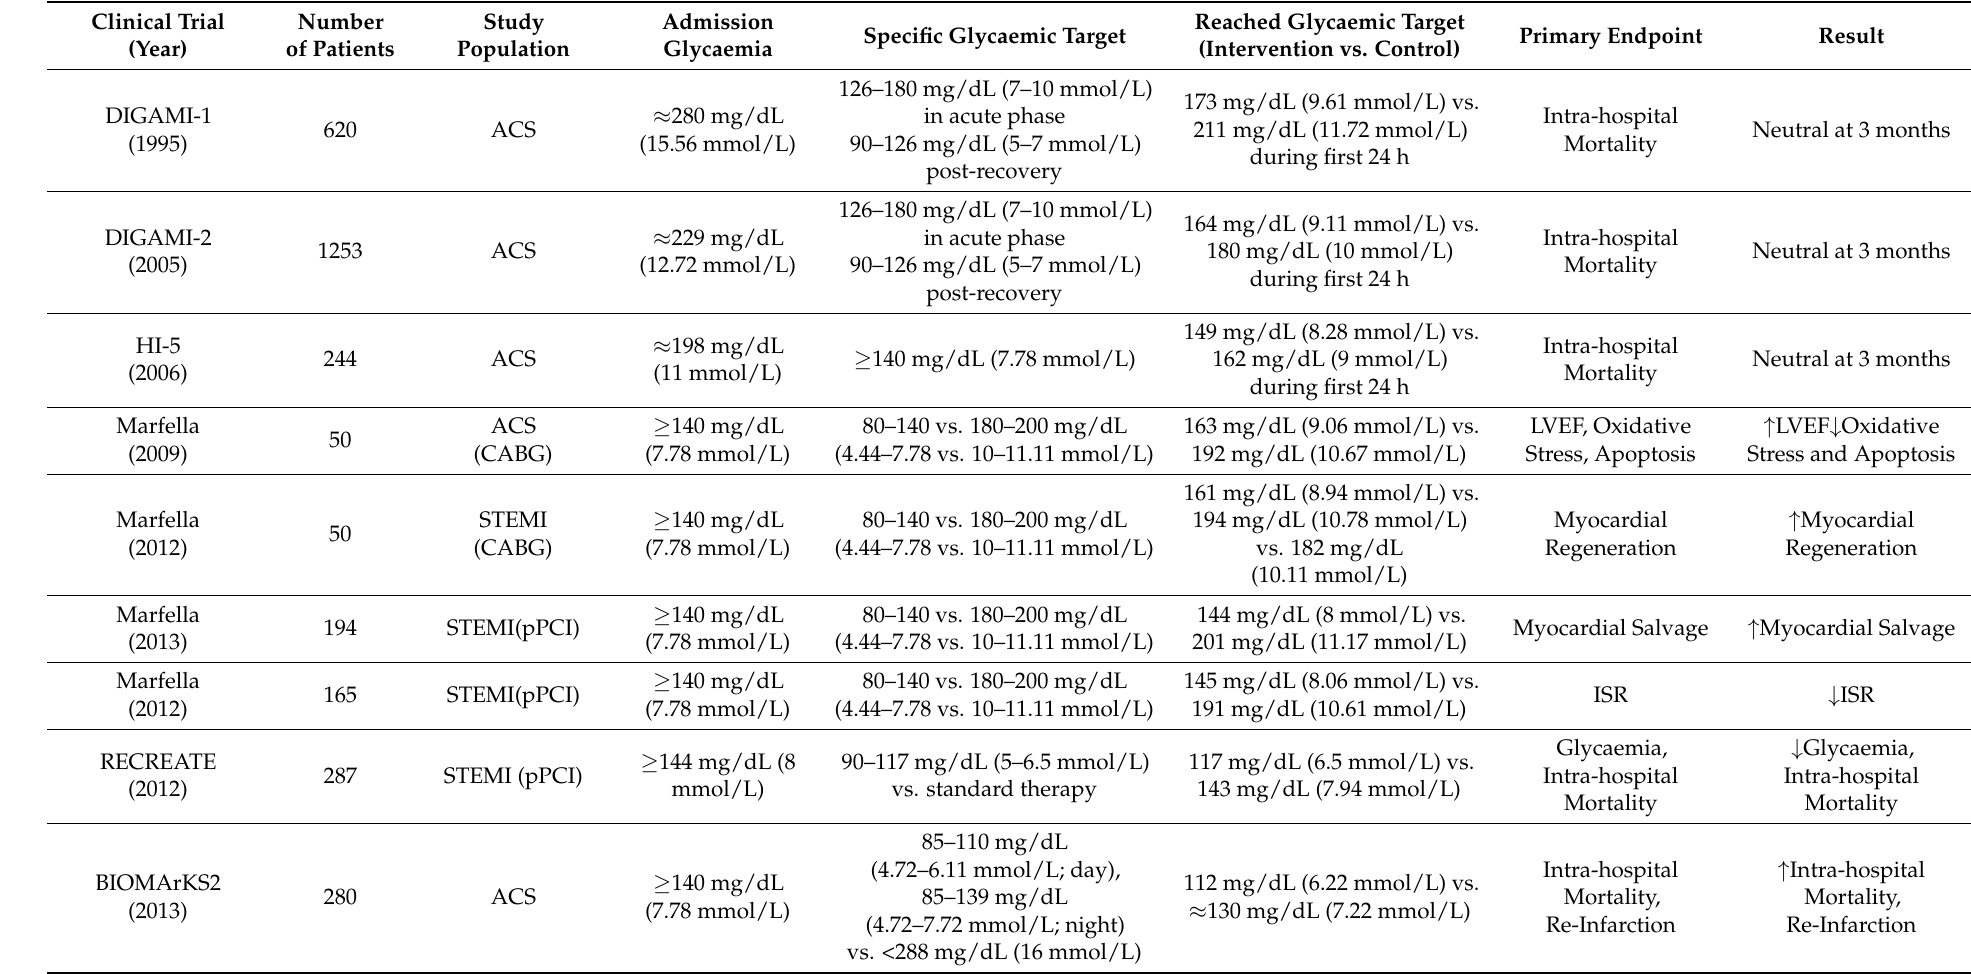
Table 1. Synopsis of randomized clinical studies designed to compare the effect of intensive glycaemic control by insulin versus standard therapy in populations comprising a large percentage of non-diabetic patients with acute hyperglycaemia at admission for acute coronary